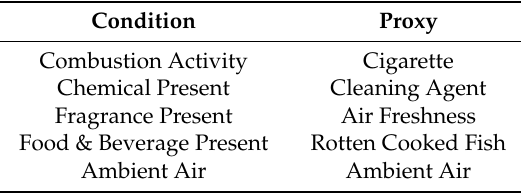
Table 4. Sources of indoor air